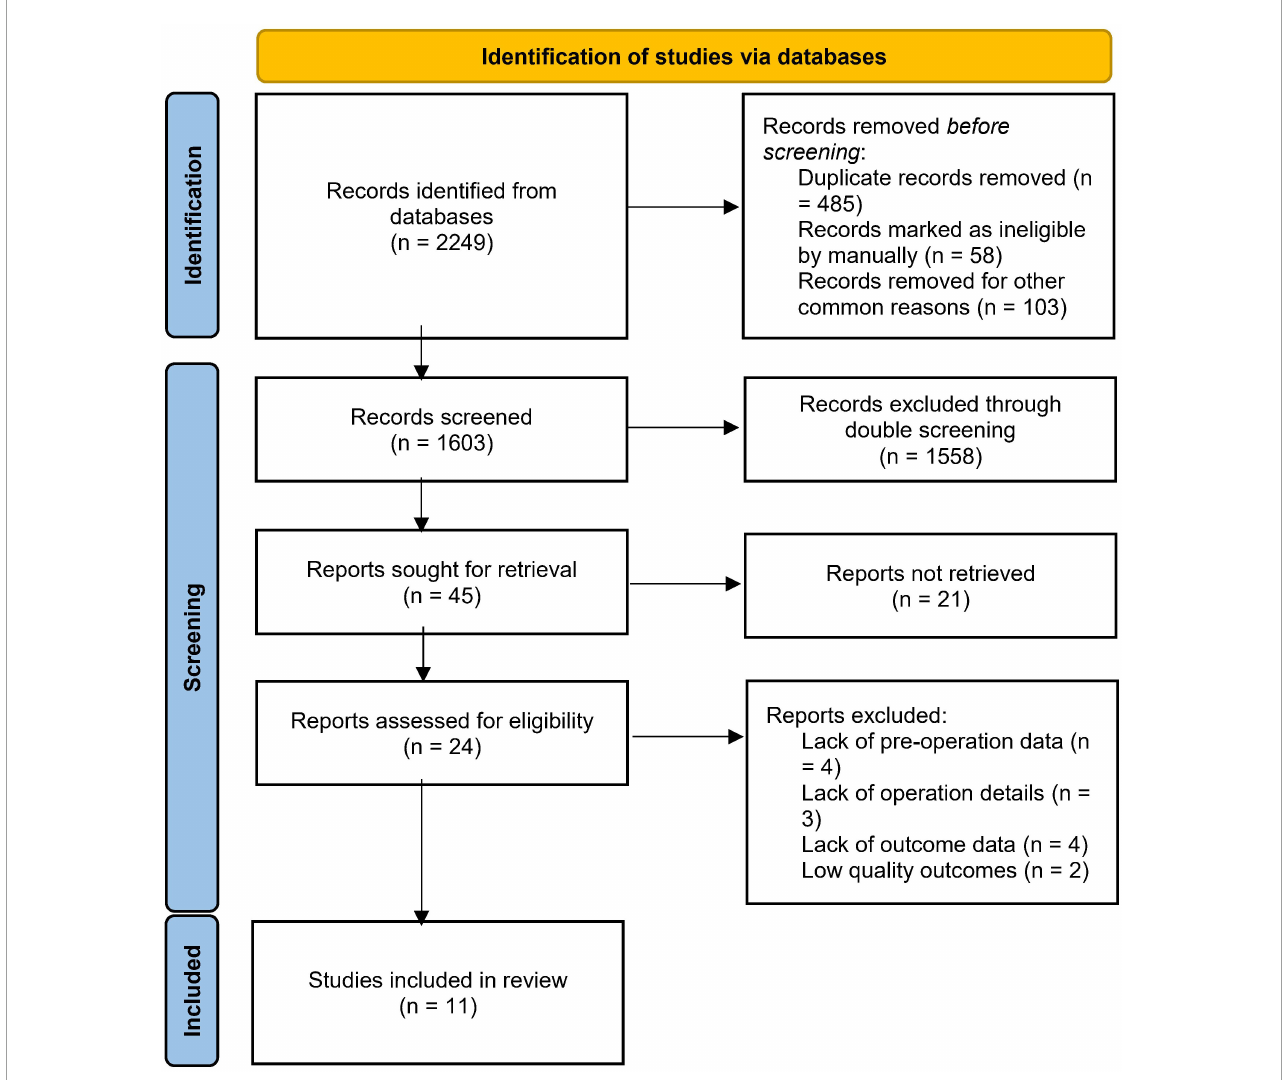
FIGURE1 Preferred reporting items for systemic review and meta-analysis (PRISMA) flow chart for literature